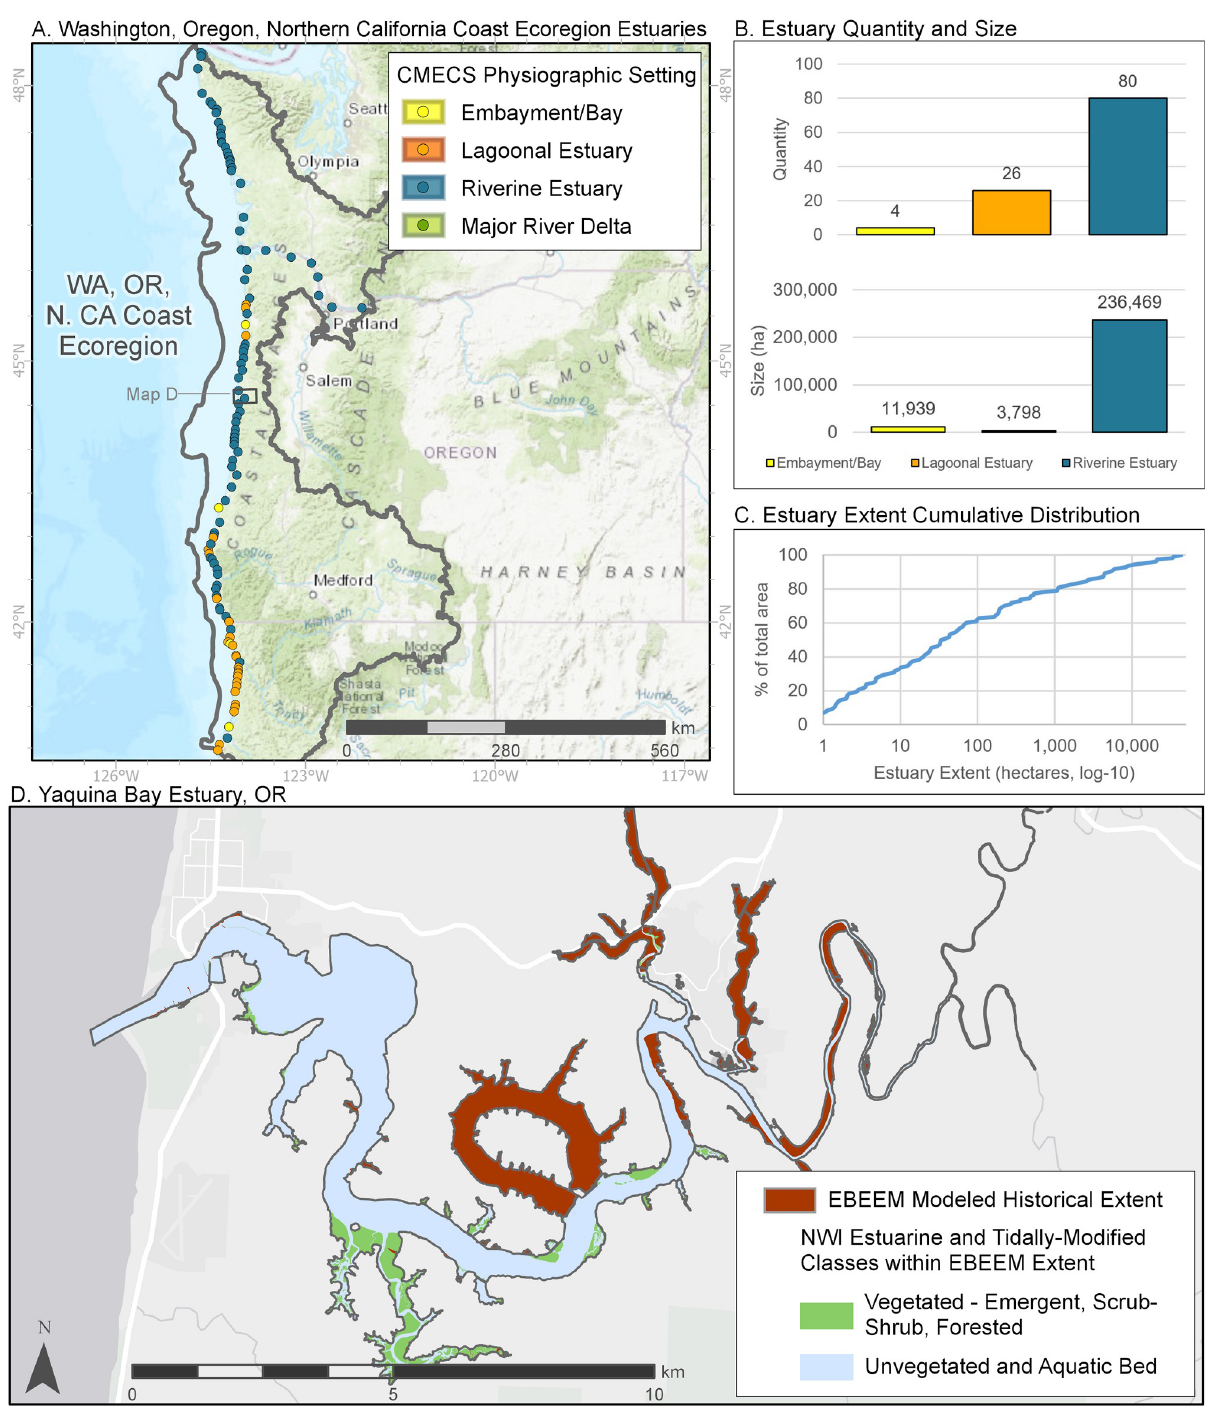
Fig 8. Summary of estuaries in the Oregon and Northern California ecoregion of the Pacific Coast. See Fig 7 for details.